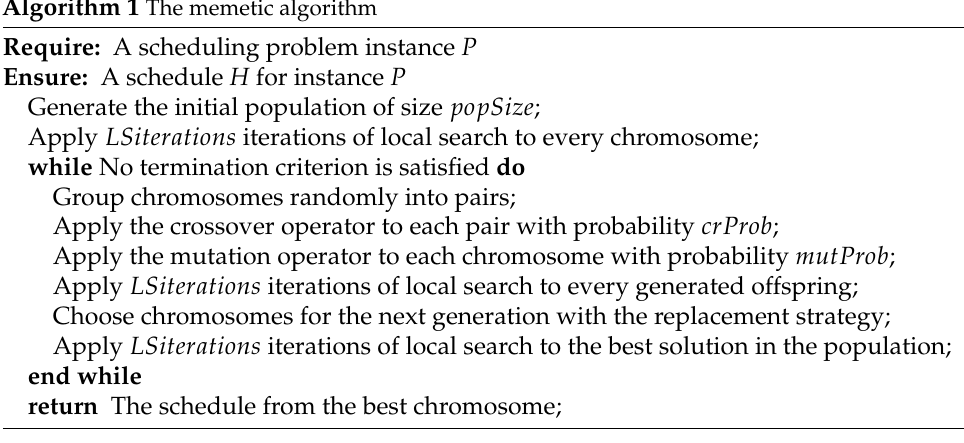
Algorithm 1 The memetic